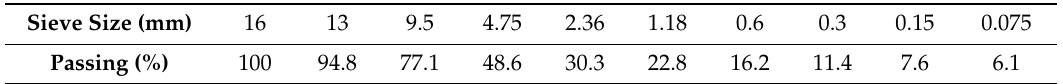
Table 2. Aggregate gradation for AC 13.